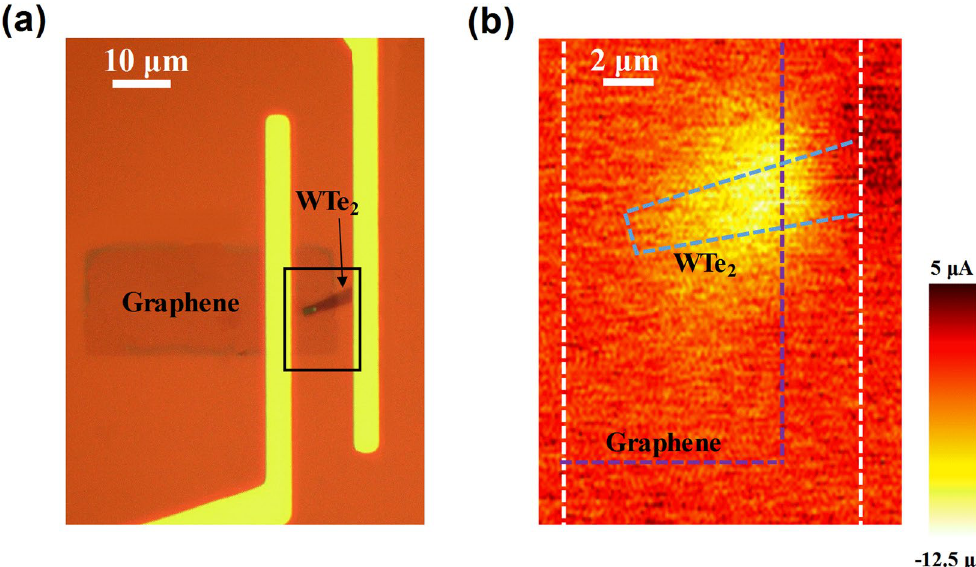
Figure 3. A staggered graphene/WTe 2 heterostructure device and photocurrent mapping. (a) An optical micrograph of the device, with graphene is staggered on top of WTe 2 flake. The area inside the black square is the scanned area. (b) Scanning photocurrent micrograph of the device acquired at V DS = 0.1 V, with 0.6 μ W power at 532 nm. Regions of photocurrent are observed in the overlapping area outlined by the WTe 2 flake (blue) with the patterned graphene film (purple). The electrodes are indicated by white dashed